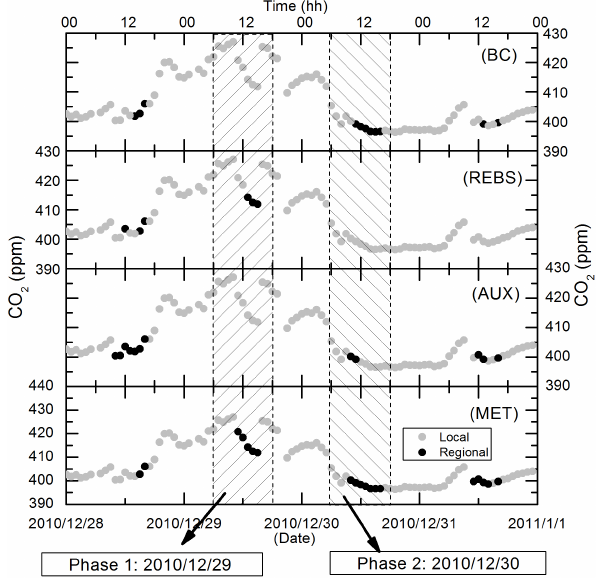
Figure 7. The filtered regional and local CO 2 mole fractions from 28 to 31 December 2010 (LT). The black dots represent the regional events and the gray dots denote the local events. The phase 1 and phase 2 represent periods from 06:00 to 16:00LT in 29 and 30 De- cember 2010,